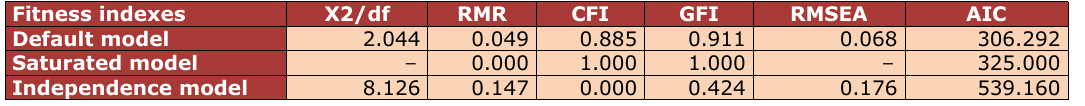
Table 3. The Fitness Index of the Integrated Model